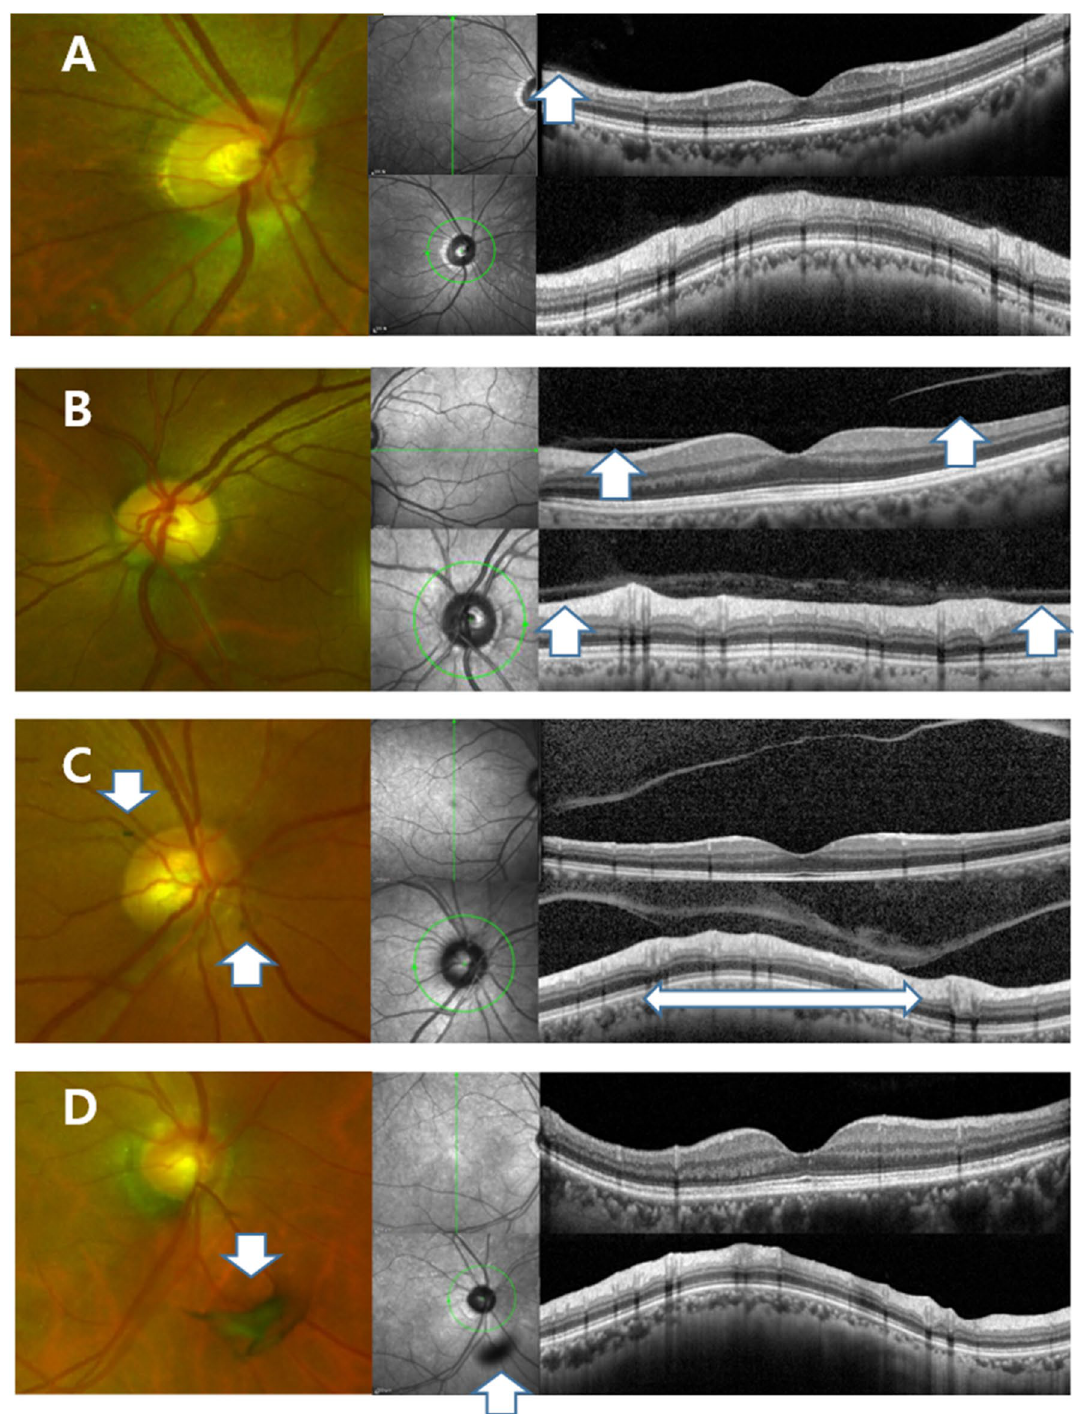
Figure 2. Ultra-wide field scanning laser ophthalmoscopy (UWF) and Spectral Domain Optical Coherence Tomography (SD-OCT) images of patients who experienced floater for the first time in their life. ( A ) PVD stage 1. 59 year-old male. No definite change was noticed around optic disc in UWF. Note subtle change which is presenting the initiation of PVD (Posterior Vitreous Detachment, white arrow). ( B ) PVD stage 2. 60 year-old female. No definite change was noticed around optic disc in UWF. In the macular SD-OCT image, perifoveal posterior vitreous detachment (PVD) is in progress (white arrows) remaining posterior vitreous attached to fovea. In glaucomatous SD-OCT, PVD is in progress in some part of the optic disc margin (arrow), while most of the optic disc remains attached to the vitreous body. ( C ) PVD stage 3. 61 year-old male. Note two pVOs (peripapillary vitreous opacity, white arrows) noticed around the optic disc. In the macular SD-OCT image, PVD occurred throughout the entire macula. In the glaucomatous SD-OCT image, PVD is in progress while about half of the optic disc margin is detached to the vitreous body (a wide bidirectional arrow). ( D ) PVD stage 4. 66 year-old female. Note a dense pVO (white arrow) resembling a Weiss ring. In the macular SD-OCT image, reflectivity of vitreous body is not observed in hollow vitreous cavity. In glaucomatous SD-OCT image, reflectivity of vitreous body is not observed either. A shadow of pVO (arrow) is